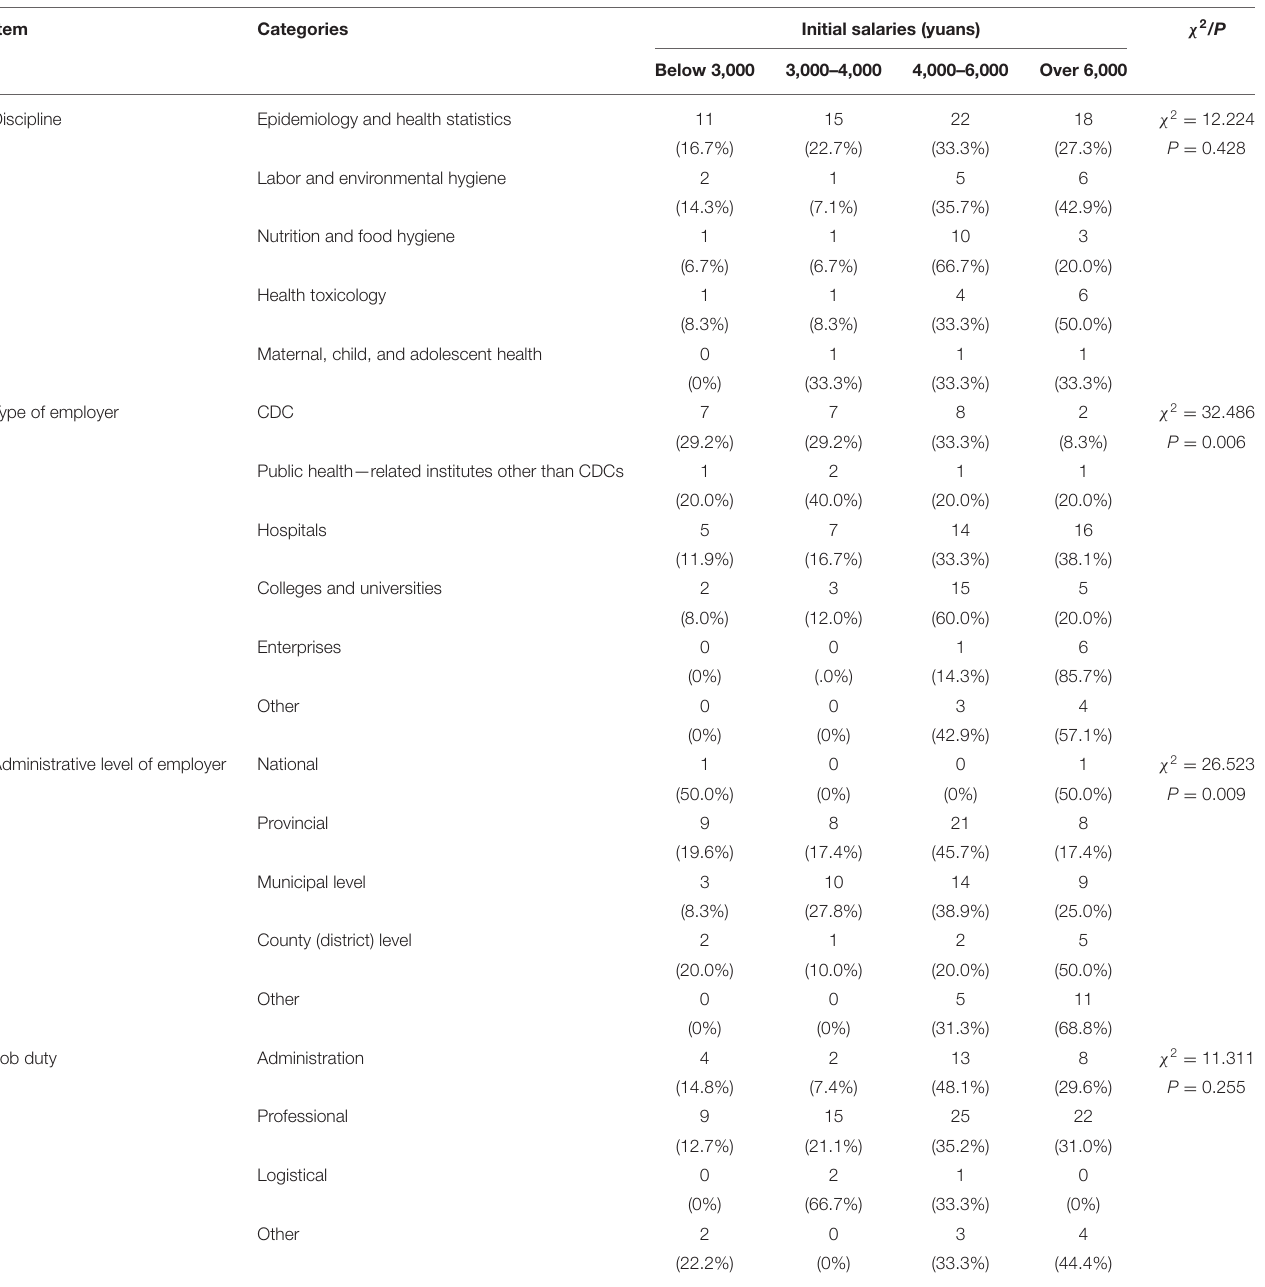
TABLE 3 | Initial salaries of PHPM Master’s